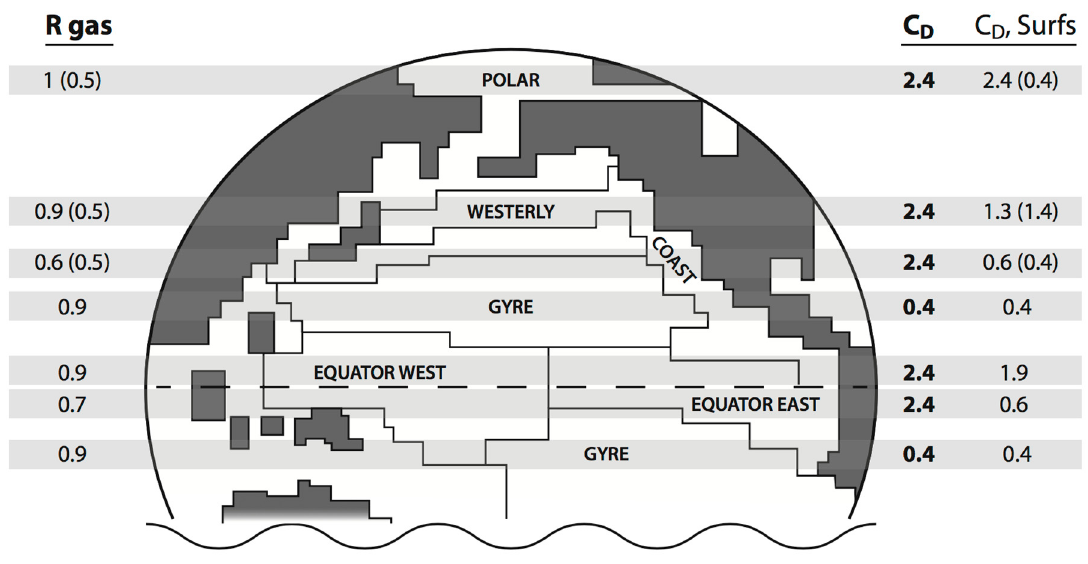
Figure 1. Schematic of a biogeographic North Pacific with our combined eco-zone names substituted for more formal, basin-specific counterparts. Sample result sets from Table 3 frame the image with their dimensionless units unchanged. Since major wind and current systems tend to follow (dictate) regional ecological boundaries, the potential is illustrated for transfer gradients to occur. Compare with bio-effects described in the abstract, results, and summary sections and also elsewhere in the text. Parentheses have the same significance as in the table, and a few complicating details have been omitted for clarity. Our calculations map equally well onto other marine basins, with extreme Southern Ocean conditions dictated by circumpolar climate coupling surrounding Antarctica. Per Table 3, R is the ratio of surfactant to clean interfacial trace gas emissions rate, at a typical wind speed. The drag coefficient is shown first unmodified in bold, then for the natural proxy spread with seasonal (bloom) dependence. Order of presentation differs slightly here since primary productivity does not change monotonically along any given longitude line. Our intent in next generation research is to develop such results into resolved dynamic maps.